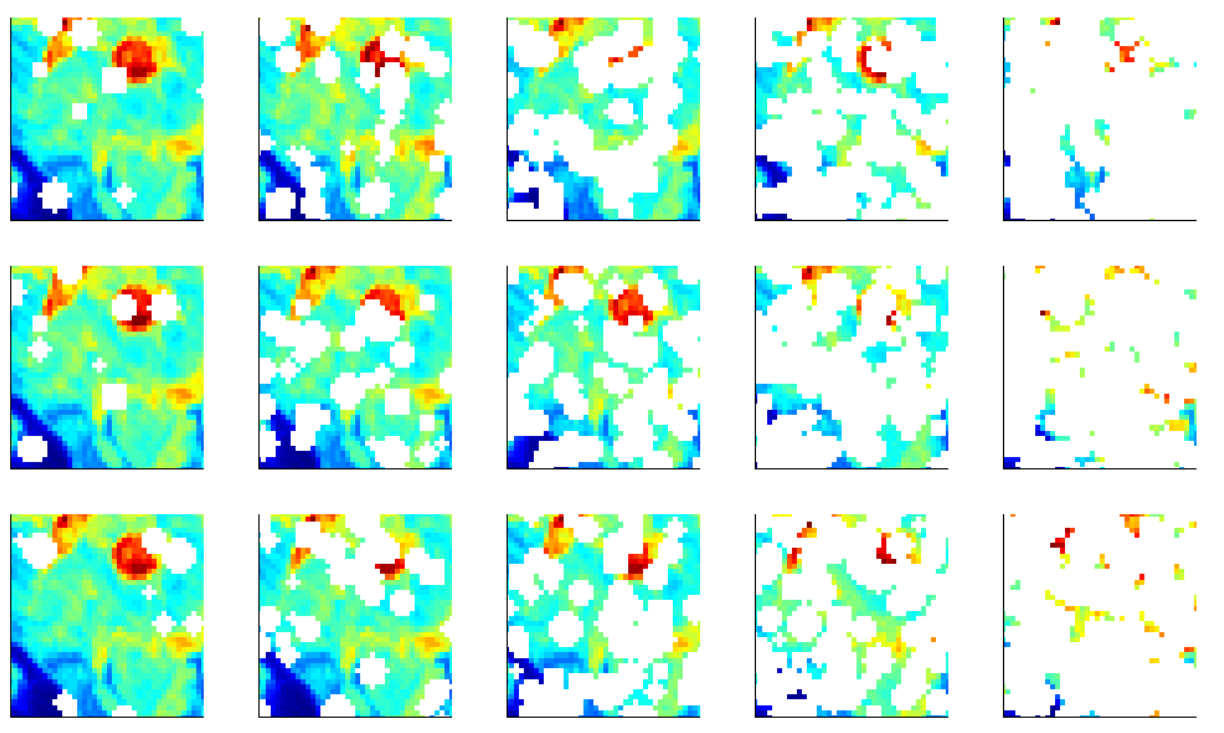
Figure 8. 3 Realizations (Rows) of the Same Image Covered Randomly in Missing Values. From Left to Right the Number of Missing Values is Increased in Each Column from 10% to 90% in Increments of